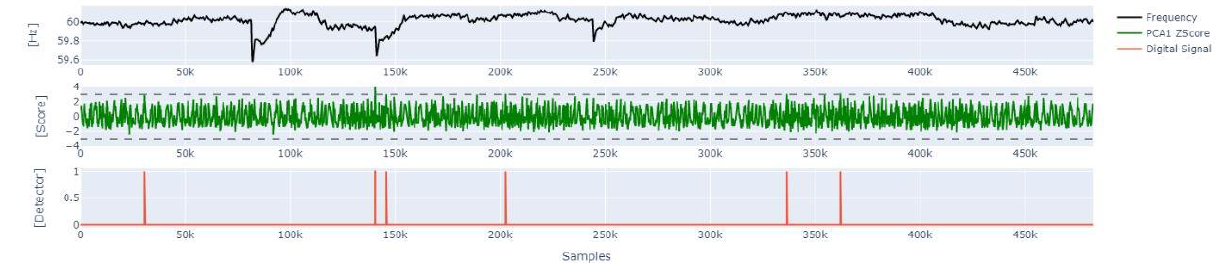
Figure 17. Event 2: detector event of PMU Itatiba (located at São Paulo State).